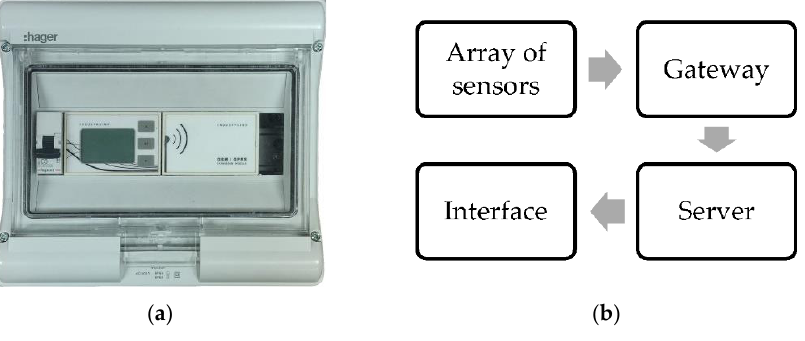
Figure 2. Gateway ( a ) and system schematics ( b